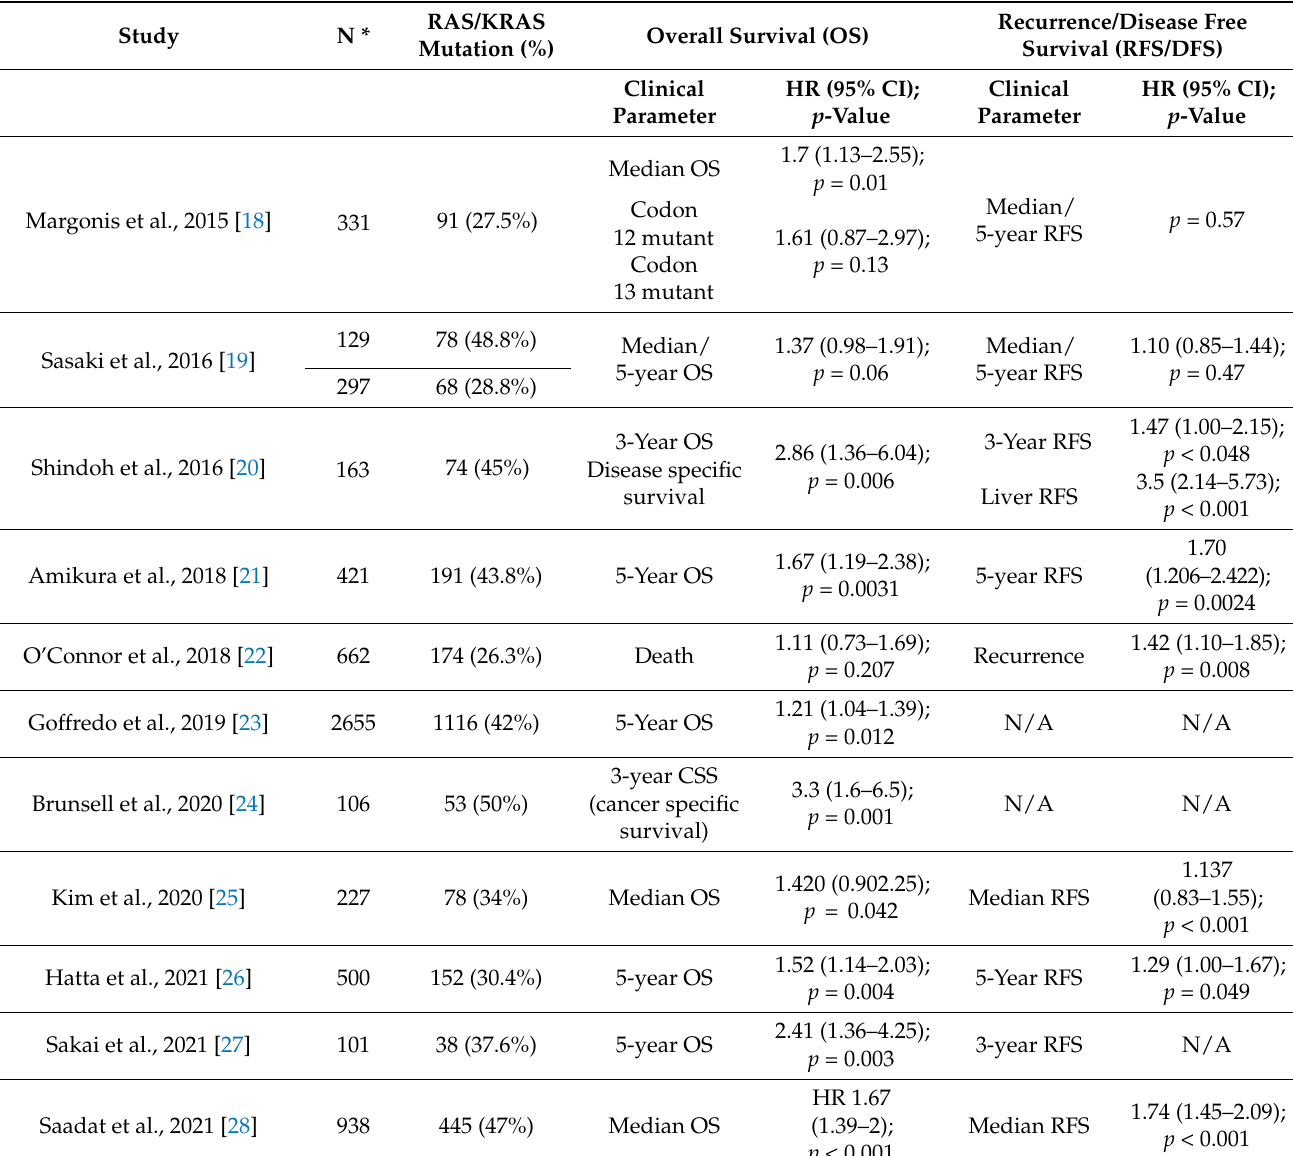
N *: Number of patients included in the study. Goffredo et al. [23] explored the prognostic factors in a large cohort of 2655 patients en- rolled from the US National Cancer Database. All patients were treated, between 2010 and 2015, for synchronous CRLM with concomitant resection of the primary tumor and metas- tases. The KRAS mutation and right-sided primary tumor were among the major prognostic factors associated with worse OS [23]. NRAS mutations, more infrequently observed, were also correlated to unfavorable oncological outcomes [29,30]. The RAS mutation was in- tegrated in two recent clinical risk scores predicting survival after CRLM resection: the genetic and morphological evaluation “GAME score” [31,32], and the “modified-Clinical risk score” (m-CRS). These scores achieved better discriminatory power than the “Fong’s